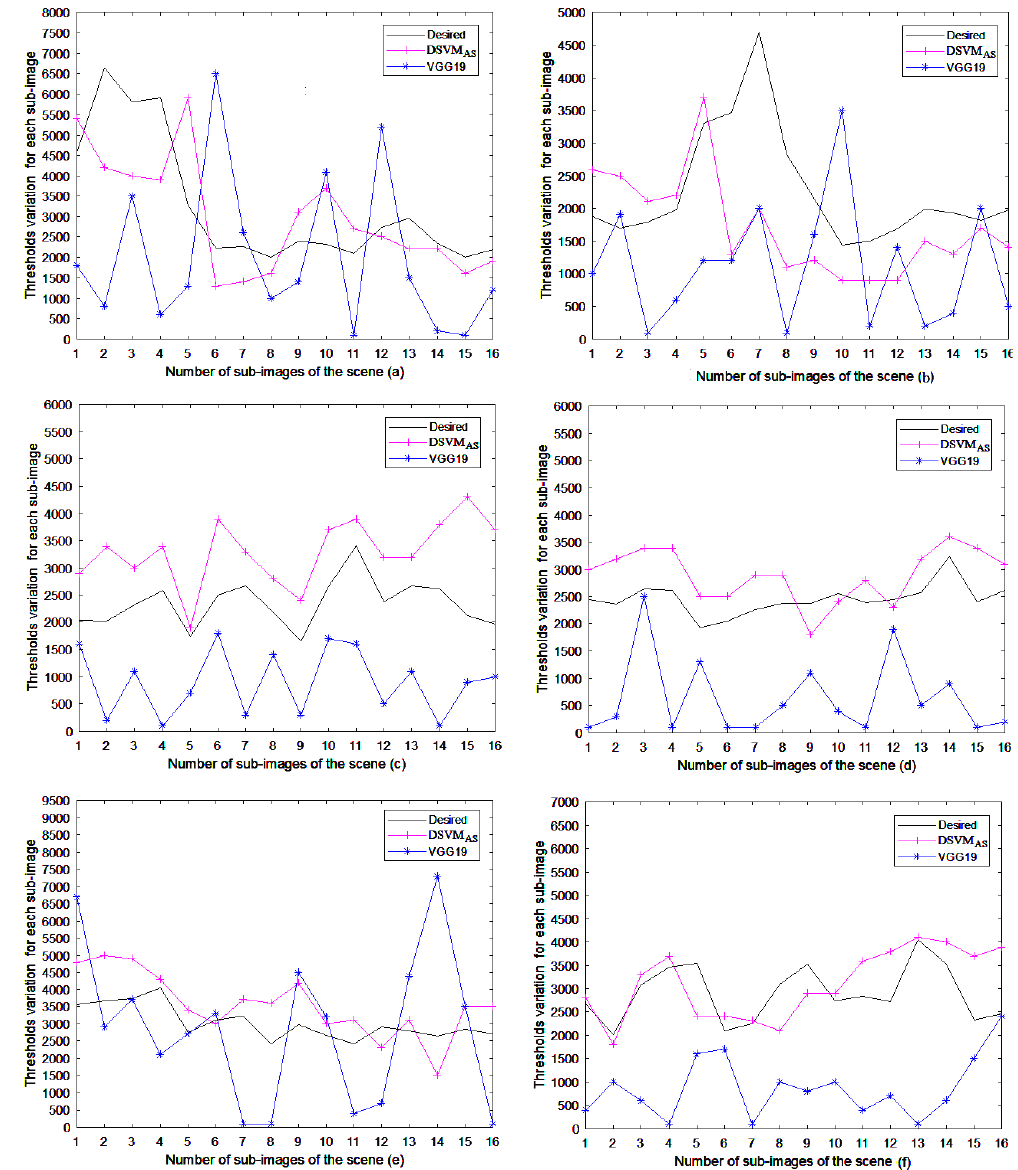
Figure 15. Variation of the actual thresholds of the VGG19 model, the human visual system score, and the DSVM AS model for the sub-images of the 512 × 512 resolution scenes. We found that DSVM AS gives more coherent results to those of the human visual system (HVS) than the VGG19 model on the scenes ( a – f